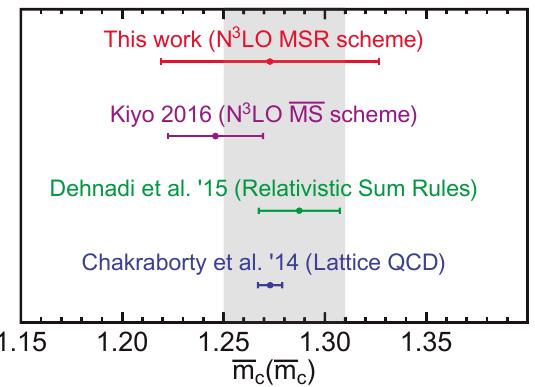
Figure 13. Comparison of various charm quark mass determinations from charmonium (cid:12)ts [red (this work) and purple], relativistic QCD sum rules (green) and Lattice QCD (blue). The PDG world average value is shown as a vertical gray